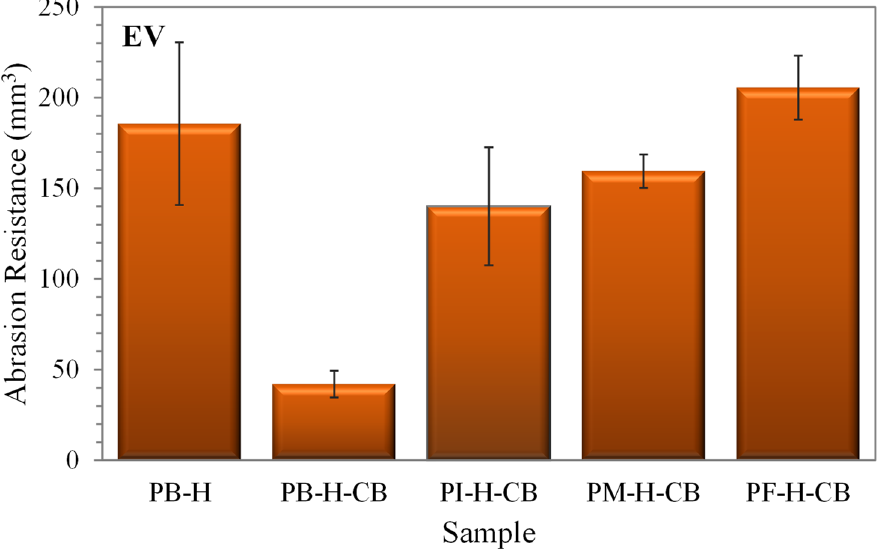
Figure 9. Abrasion resistance of reinforced and unreinforced compounds evaluated with EV system.